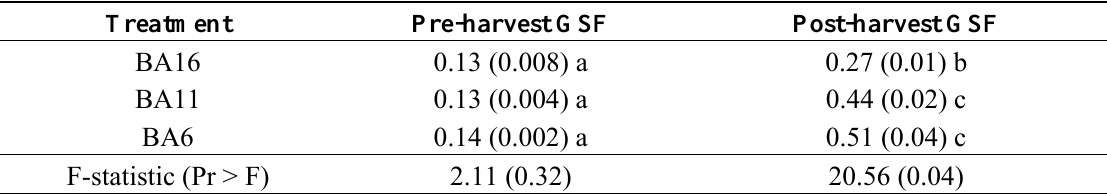
Table 2. Comparisons of pre-harvest (IO) and post-harvest treatment mean GSF